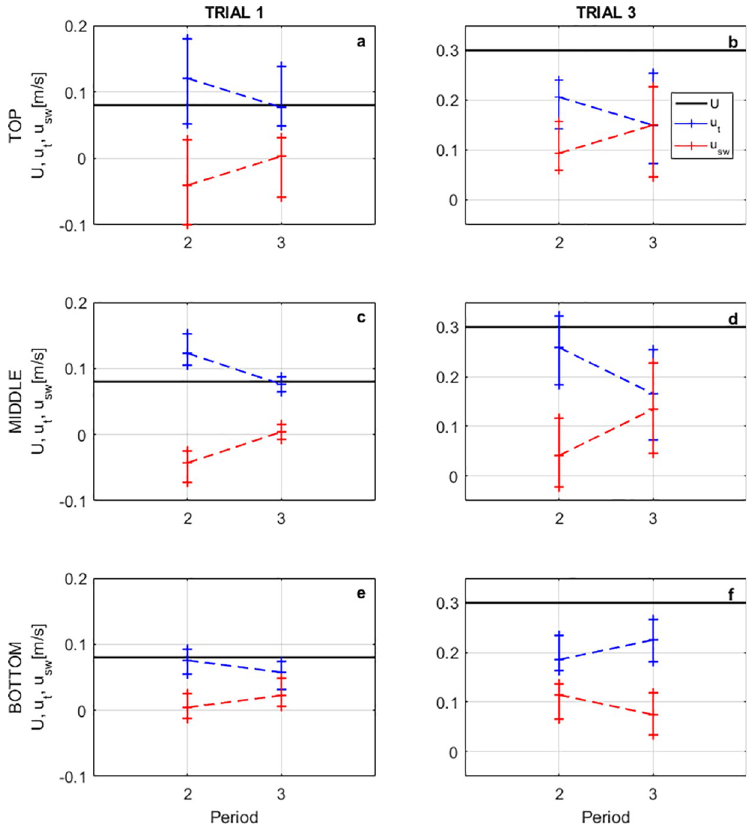
Fig 9. Variation of larvae traveling and swimming speeds between periods 2 and 3 analyzed at each of the three water profile regions. (a,c,e) Trial 1. (b,d,f) Trial 3. For each region in water profile: top (a,b), middle (c,d), and bottom